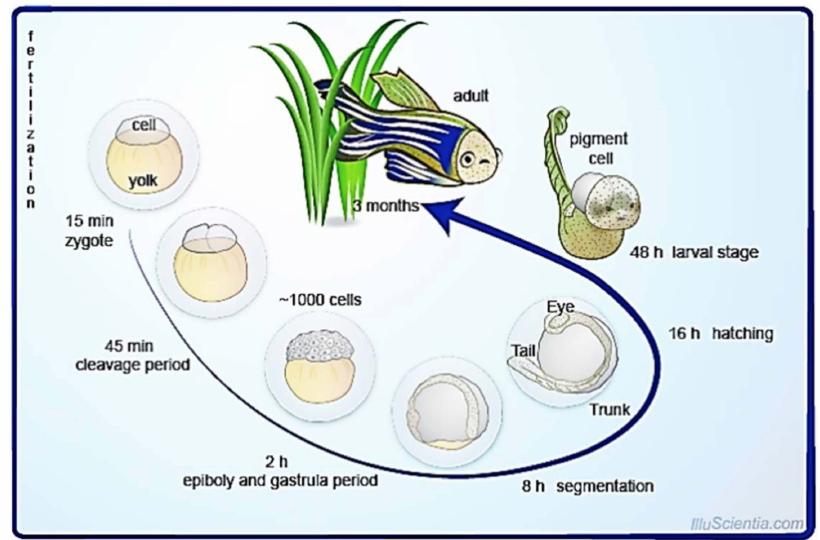
Figure 1. Developmental stages of zebrafish. Figure is reused under the permission obtained from Creative Commons Attribution-ShareAlike License